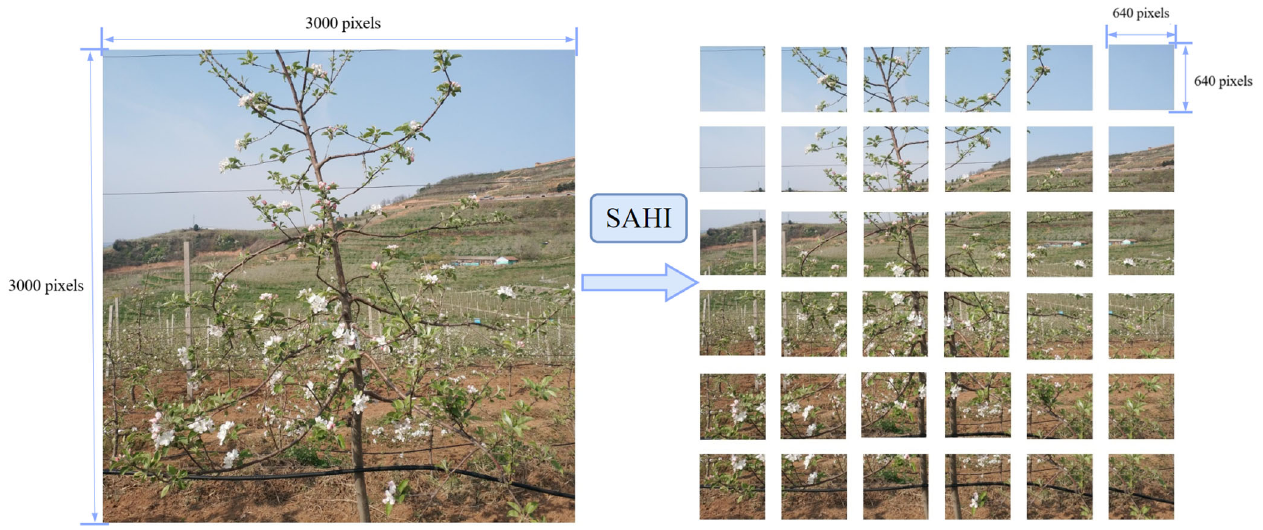
Figure 3. The process of SAHI splitting the original image.